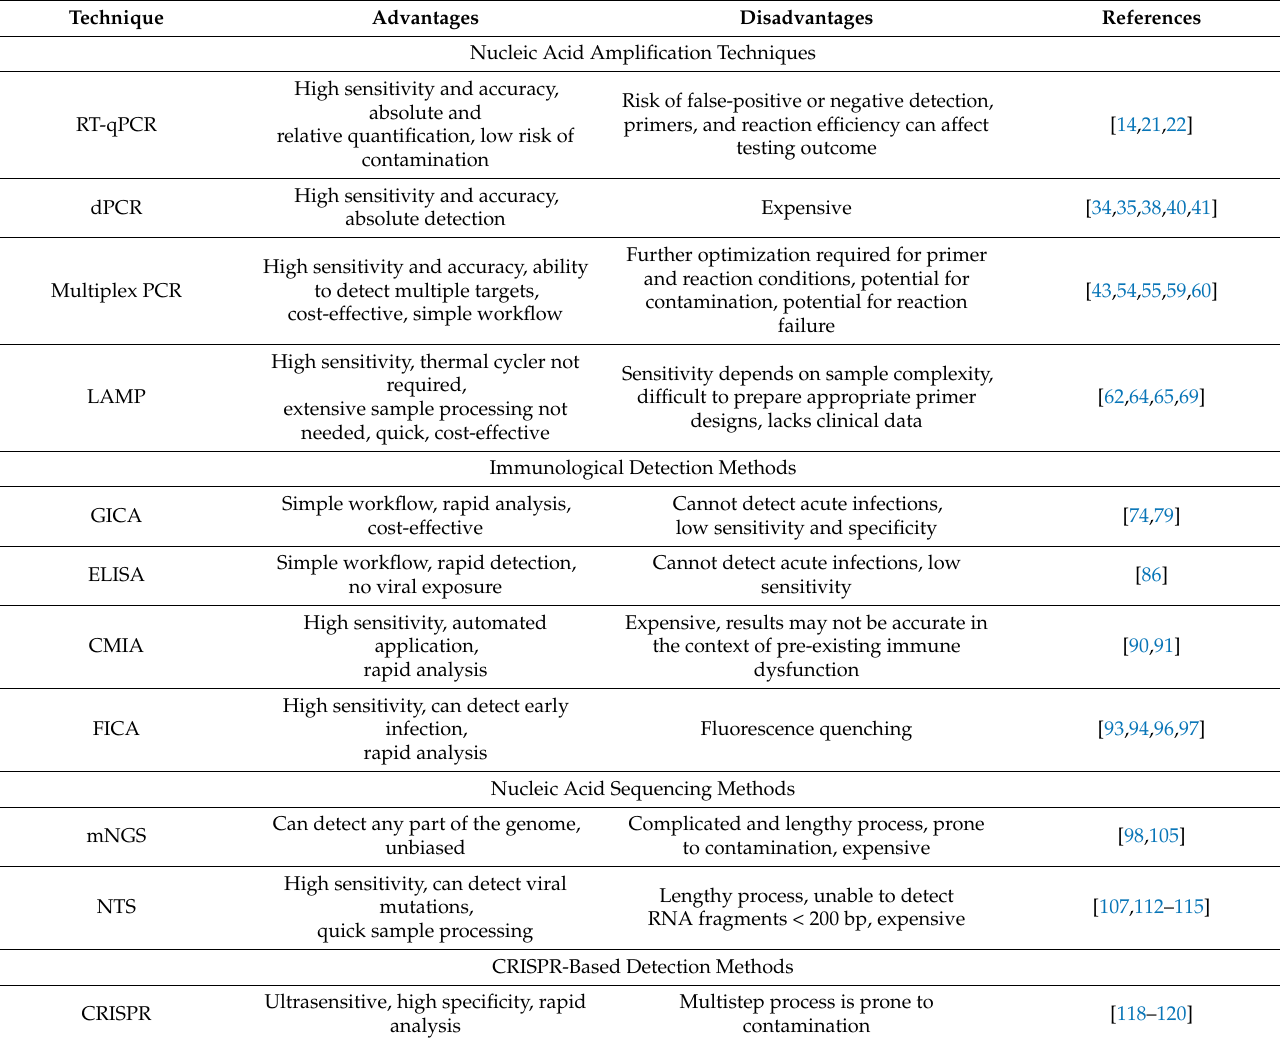
Table 1. Summary of the main advantages and disadvantages of methods used to detect SARS-CoV-2 infection. Technique Advantages Disadvantages Nucleic Acid Amplification